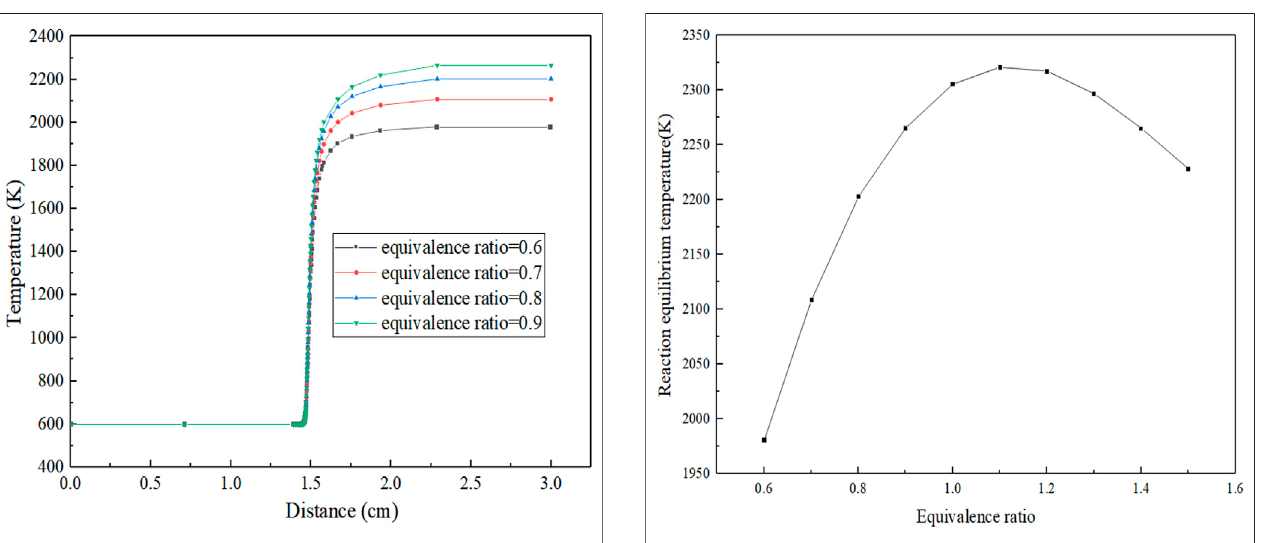
FIGURE 7 | Variation law of reaction equilibrium temperature with equivalence